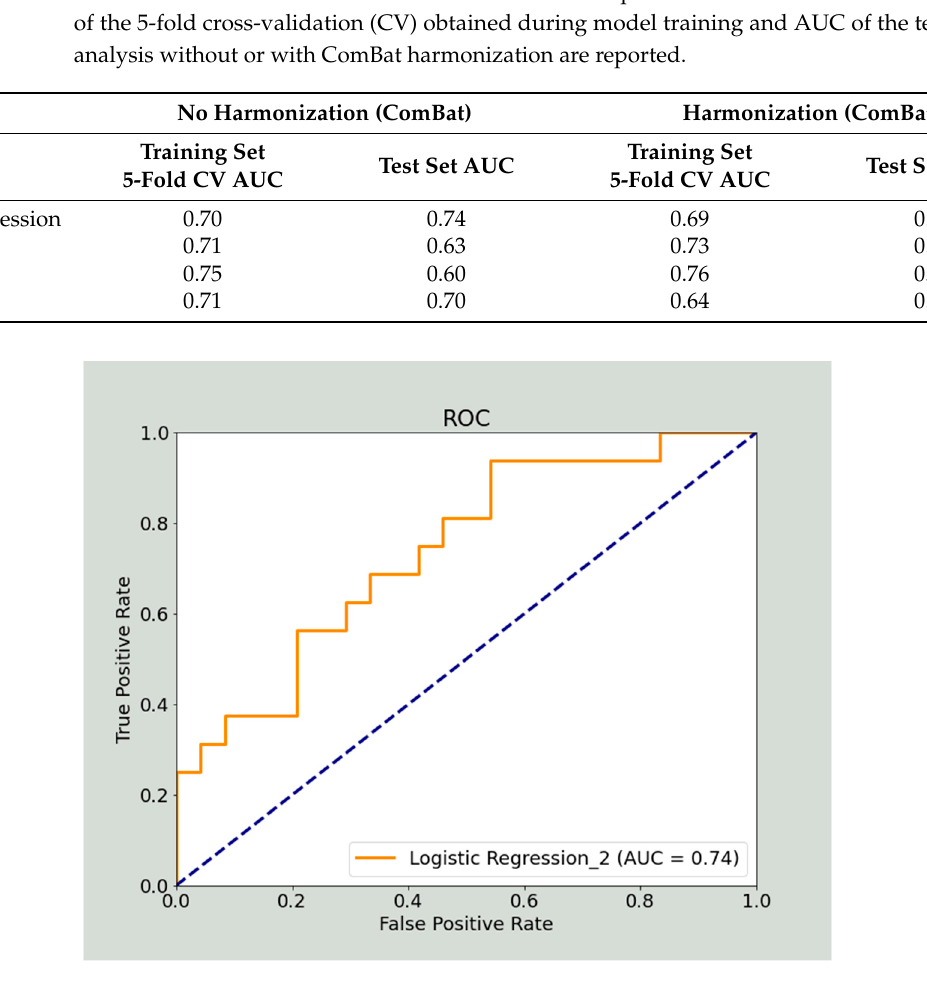
Figure 3. ROC curve of the best performing model given by the clinical–radiomic model for the BRCA mutation prediction, obtained by applying the penalized logistic regression to non-harmonized data .